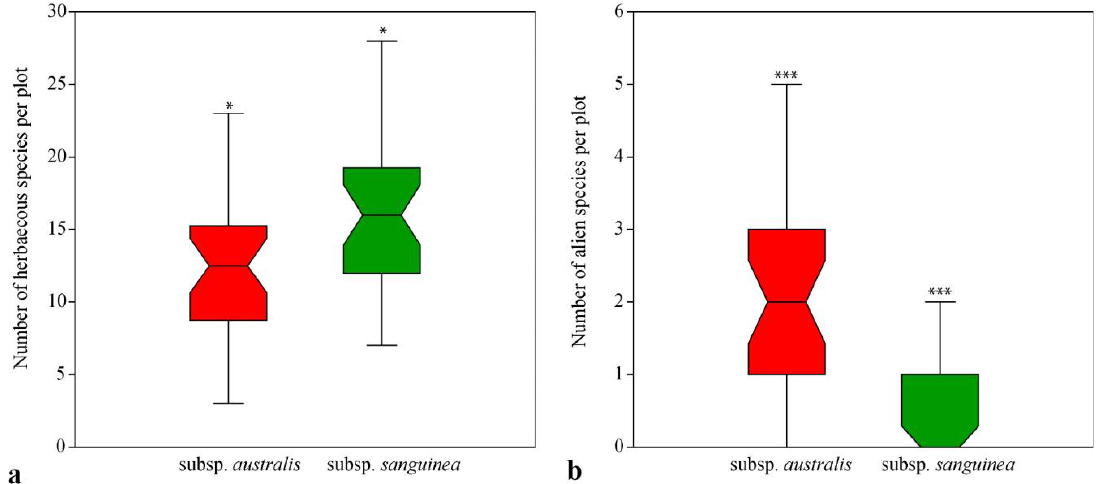
Figure 4. Comparison of the number of herb species ( a ) and the number of alien species ( b ) between study plots with Cornus sanguinea subsp. australis and Cornus sanguinea subsp. sanguinea. Asterisks above the whiskers indicate the differences between all study plots according to the results of the two-sample Mann – Whitney test (* — p < 0.05; *** — p < 0.001). Communities with alien subsp. australis were more diverse than communities with native subsp. sanguinea when considering the number of alien species. In the study plots with subsp. australis , a total of 27 alien species were recorded, while in the study plots with subsp. sanguinea , 9 alien species were recorded. The mean number of alien species in the study plot was 3.5 ± 1.6 (median 3), while the mean number of alien species in the study plot with the native subspecies was 0.6 ± 1.1 (median 0). It was found that, in com- munities with subsp. australis , the diversity of alien plant species was significantly higher (U = 60.5; p < 0.001) than in communities with subsp. sanguinea (Figure 4). However, the overall frequency of alien species was low, with most of them being recorded in only one study plot. The most common alien species in communities with subsp. australis were Physocarpus opulifolius (L.) Maxim. (recorded in 26.7% of study plots), Acer negundo L. (16.7%), Amelanchier spicata (13.3%), Ligustrum vulgare (13.3%), and Impatiens parviflora DC. (13.3%). Nevertheless, in the individual study plots, alien species were quite abundant: Physocarpus opulifolius covered from 0.5% to 30% of the plot surface, Acer negundo cover ranged from 5% to 15%, and Impatiens parviflora covered from 10% to 25%. In communities with subsp. sanguinea , the most frequent alien species were Impatiens parviflora (recorded in 16.7% of study plots) and Ligustrum vulgare (10.0%). Impatiens parviflora cover in these communities ranged from 1% to 10%, and the cover of Ligustrum vulgare ranged from 0.5% to 1%.